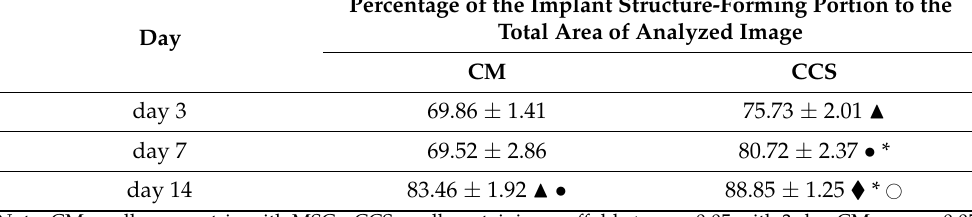
—comparison with